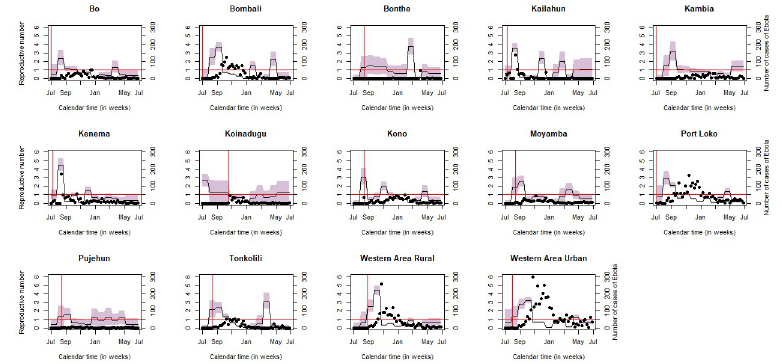
Fig 3. Effective reproductive number (black solid line) with its 95% credible interval. The horizontal dashed red line corresponds to R t = 1. The vertical dashed red line indicates where exactly the epidemic starts. These results correspond to the model with informative priors. The curves were produced based on Model 3. The model assumes constant mean transmission rate, constant incubation and constant infectious period across the